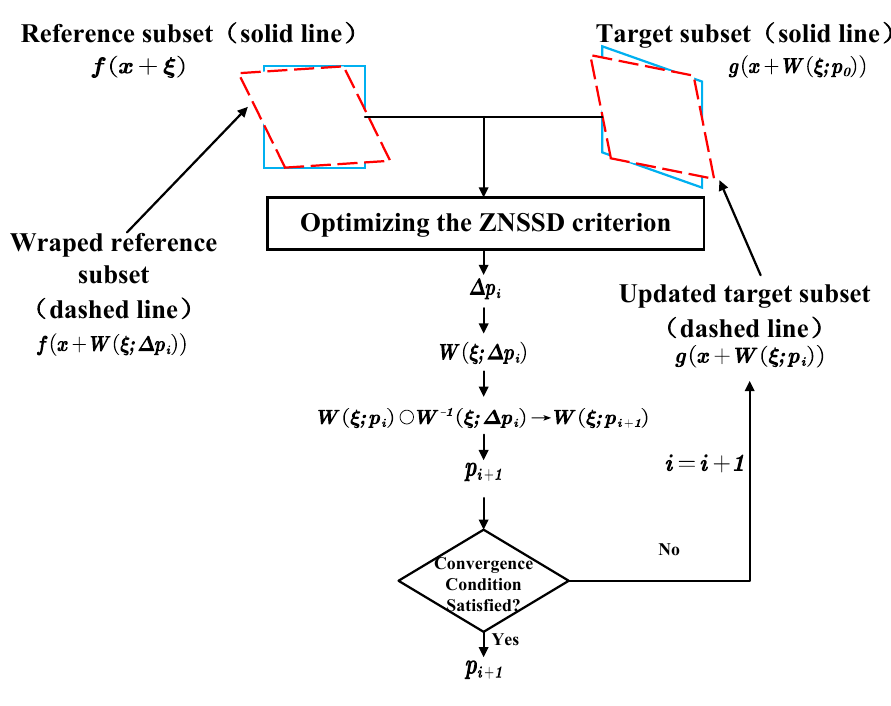
Figure 2. IC-GN sub-pixel search flow